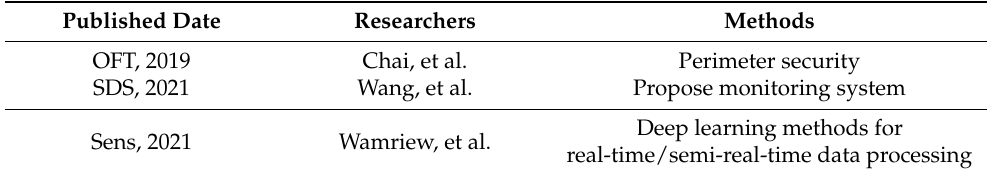
Figure 25. Deep convolutional neural network architecture used in the study. Green, blue, and red cuboids represent multi-channel feature maps with the number of channels shown at the bottom of the cuboids [86]. Table 9. Summary of energy exploration applications.